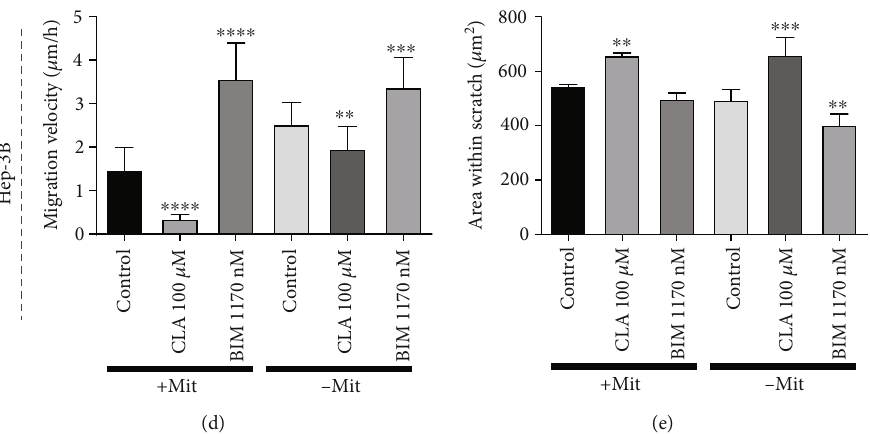
Figure 3: CLA treatment inhibited in vitro migration of HCC cell lines. (a), (b), (d) Scratch assay analysis showed that CLA treatment (Sk- Hep-1: 60 μ M, Hep-3B: 100 μ M) reduced the migration velocity of both HCC cell lines with or without mitomycin C treatment as compared to the control groups. However, BIM treated groups (Sk-Hep-1: 780nM, Hep-3B: 1170nM) showed enhanced motility in both experimental groups. (c), (e) The scratched areas that remained vacant were larger in CLA treated groups in comparison with control groups in both cell lines. BIM treatment in both cell lines resulted in an enhanced motility of cells and covering of almost all scratched areas. Data are presented as the mean ± SD , n = 3 ( ∗ p < 0 : 05 , ∗∗ p < 0 : 01 , ∗∗∗ p < 0 : 001 , and ∗∗∗∗ p < 0 : 0001